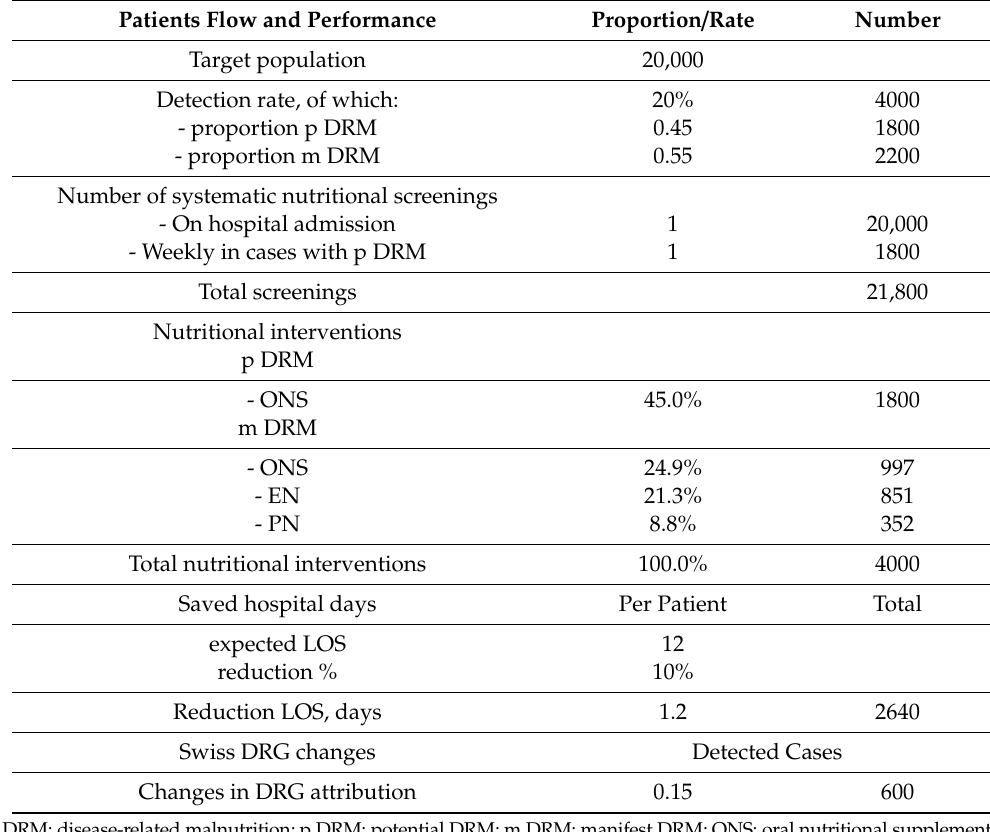
Table 3. Patient flow and resource use in connection with a systematic nutritional screening (NS). Patients Flow and